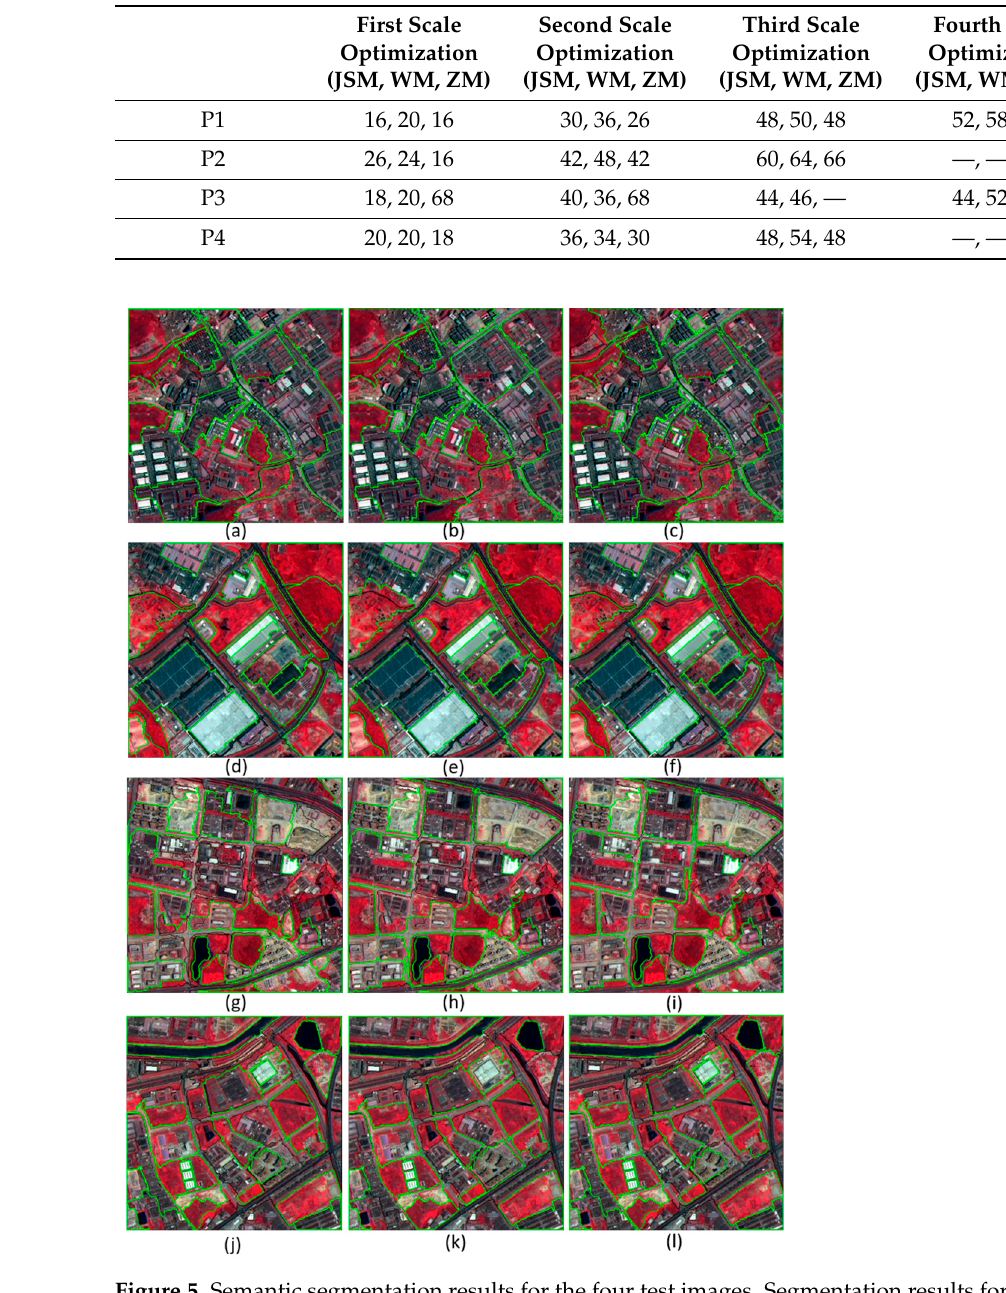
Figure 5. Semantic segmentation results for the four test images. Segmentation results for ( a - c ) P1, ( d - f ) P2, ( g - i ) P3, and ( j - l ) P4. The first, second, and third columns show the results of JSM,